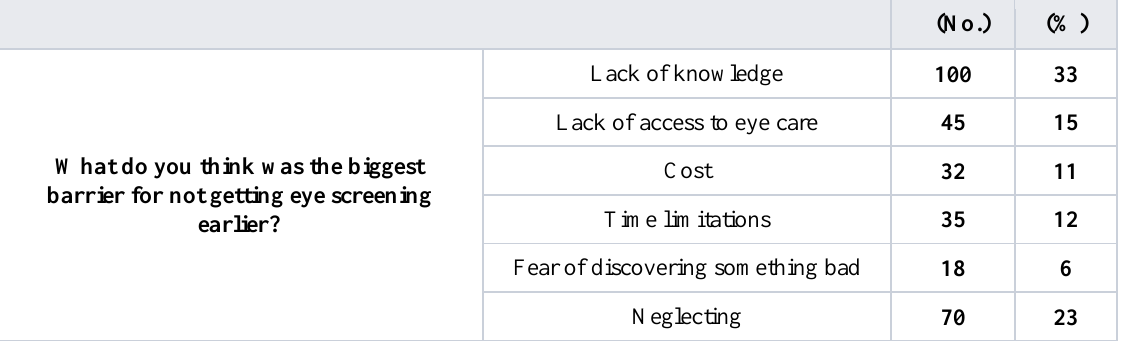
What do you think was the biggest barrier for not getting eye